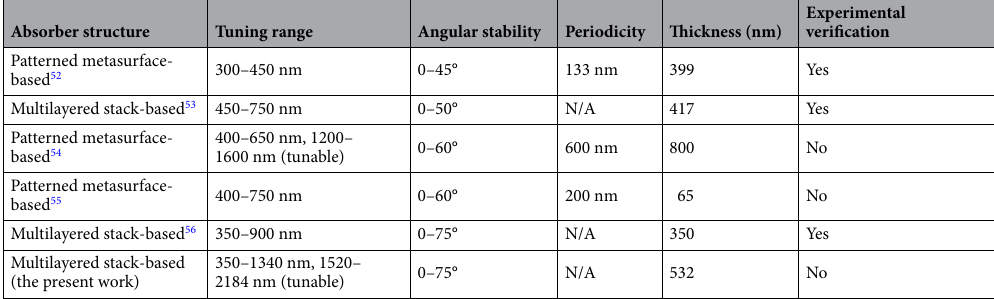
Table 1. Comparison of the features of the previously reported metamaterial absorbers with the proposed GST-graphene-based